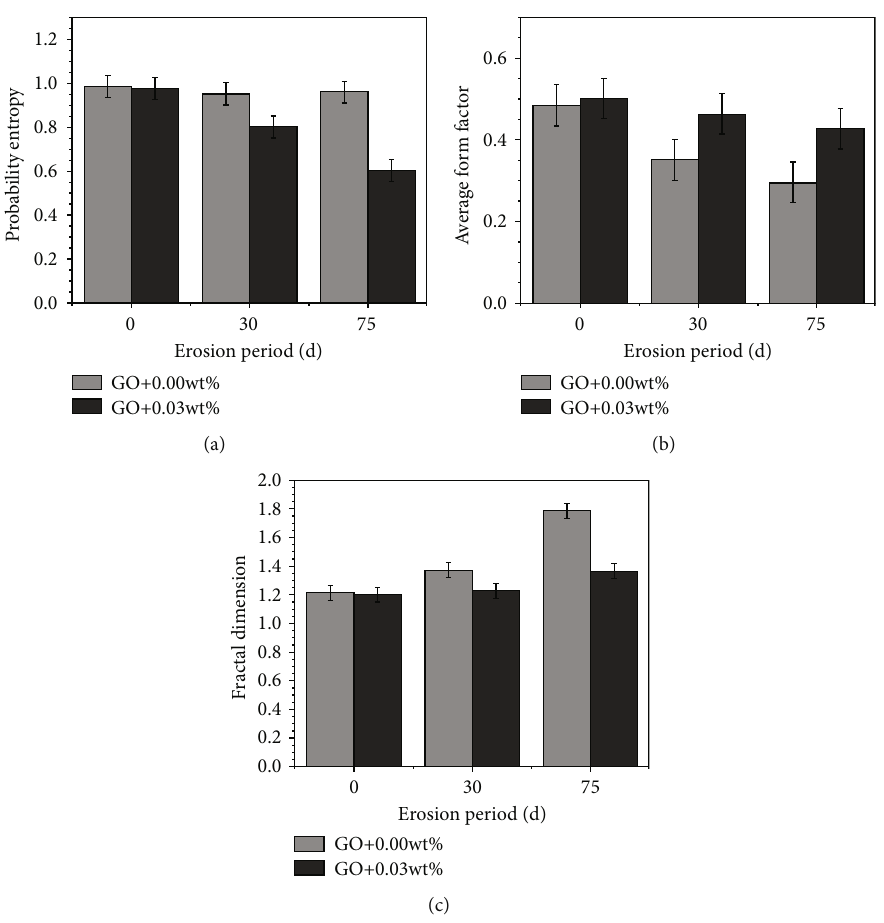
Figure 10: Pore parameters: (a) probability entropy, (b) average form factor, and (c) fractal